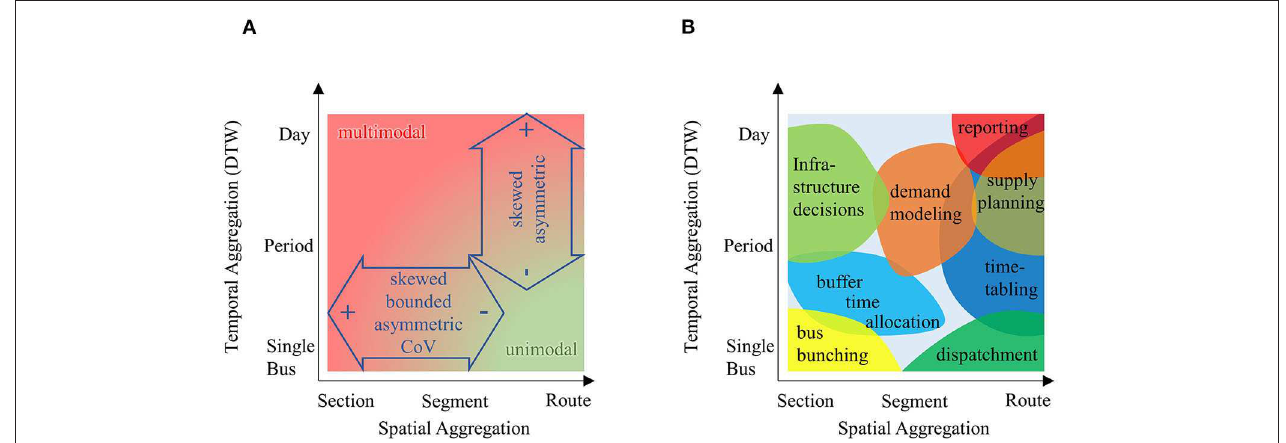
FIGURE 5 | Graphical summary of results from the literature and recommended research Partlabels: (A) Descriptive Analytics, (B) Prescriptive/Predictive